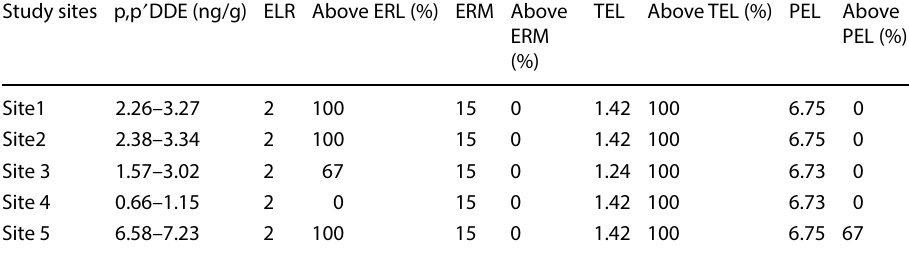
Table 5 Comparison between p,p ʹ DDE levels in Lake Ziway at different sites and sediment concentrations as guideline values (ng g − 1